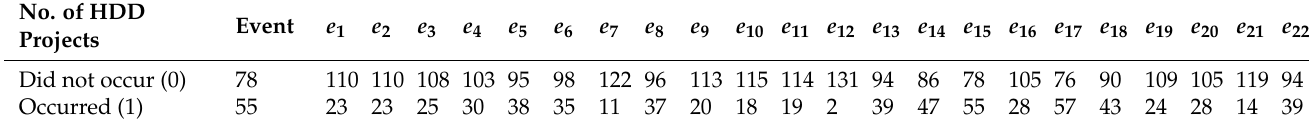
Table 3. The structure of the analysed data set in terms of the number of occurrences of particular unwanted events. No. of HDD Projects